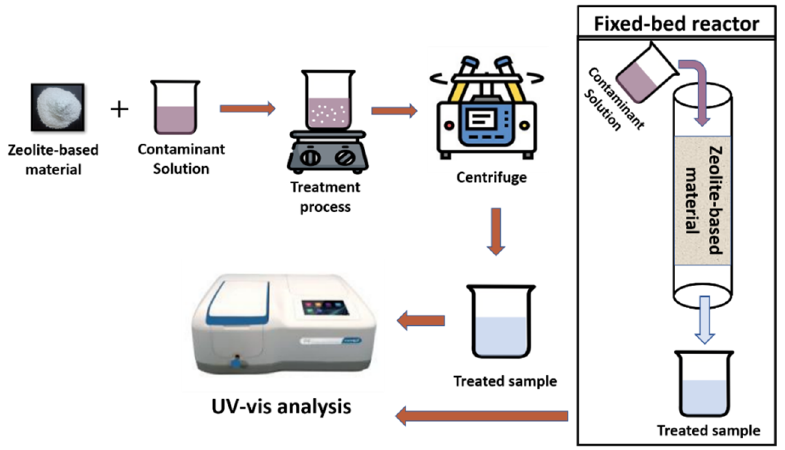
Figure 14. Schematic representation of pollutant removal process using zeolite-based materials.